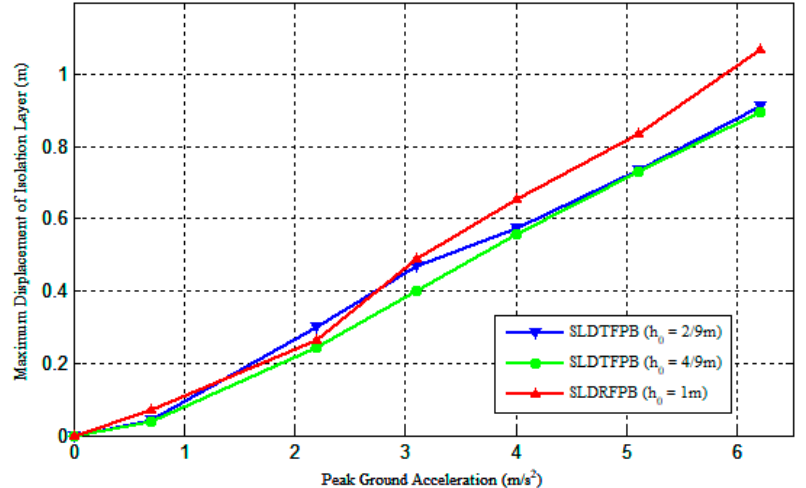
Figure 17. Maximum displacements of isolation layers equipped with SLDTFPB or SLDRFPB.